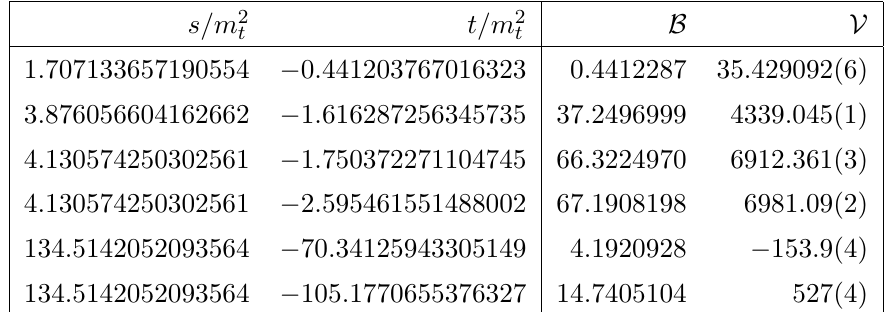
Table 3 . Numerical results for various phase space points at the scale µ 2 parentheses gives the numerical uncertainty on the last digit of the virtual